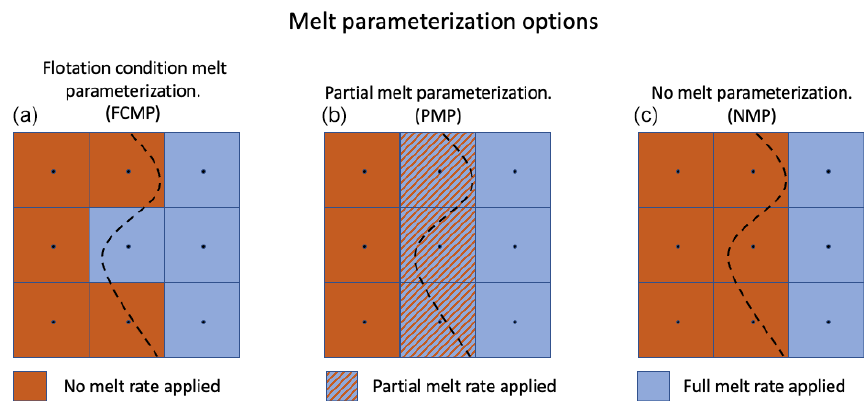
Figure 3. The different melt parameterizations applied in cells containing the grounding line. The grounding line (black dashed line) can be located in cells where ice is considered fully grounded and where no melt rate is applied (brown), in cells where ice is fully floating and where the full melt rate is applied (blue), and in cells that are partially floating/grounded, where a partial-melt rate can be applied (blue with brown stripes). We consider three melt rate parameterizations. Cells containing the grounding line experience one of the following: no melt or full melt depending on a flotation criterion (FCMP, a ), partial melt proportional to the fraction of the cell that is floating (PMP, b ), or no melt (NMP, c ). Black circles show cell centers, where the flotation criterion is applied for the FCMP.